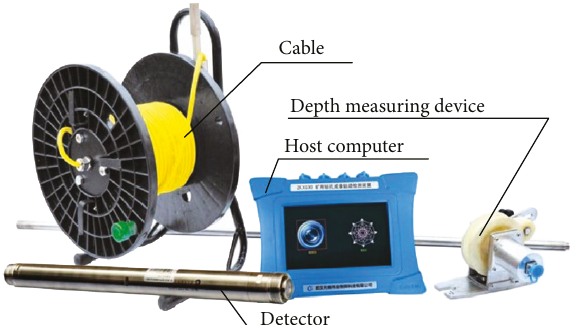
Figure 5: ZKXG-30 drilling TV detection equipment.